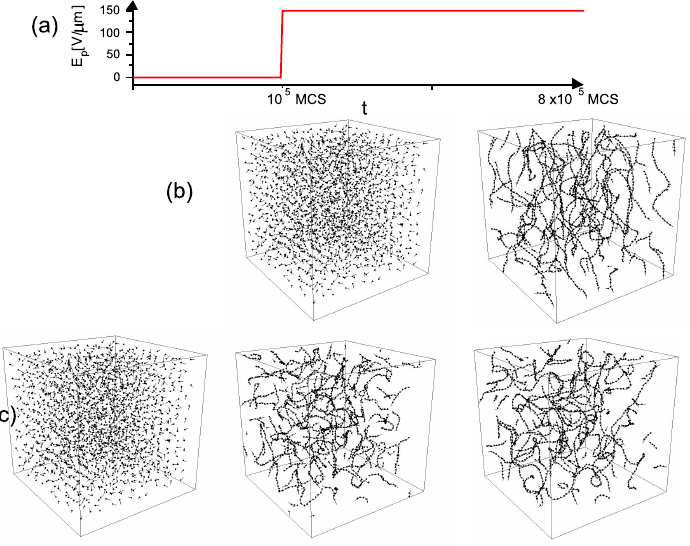
Figure 24. ( a ) Poling electric field as function of number of MC steps. ( b ) Configurations of dipoles: immediate poling; ( c ) pre-poling scenario. Horizontal alignment corresponds to time from top plot: t = 0, 10 5 MCS and 8 × 10 5 MCS. Polymeric chains are not